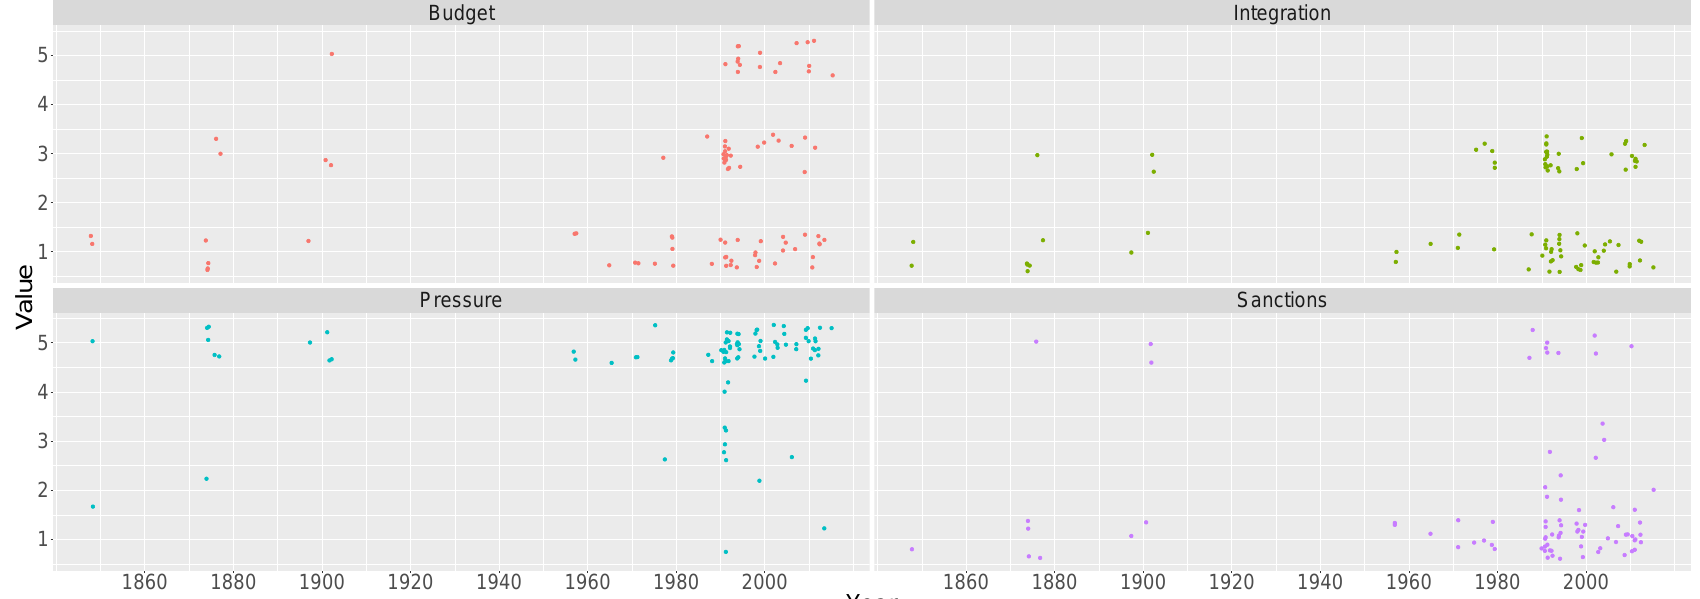
Figure 4. Policy design trends. Note: Panels show four policy design indicators; dots stand for 92 Swiss national-level flood policies; x-axis indicates time frame of analysis between 1848 and 2017; y-axis shows the categorical values, between one and five, of policy design indicators (see Table